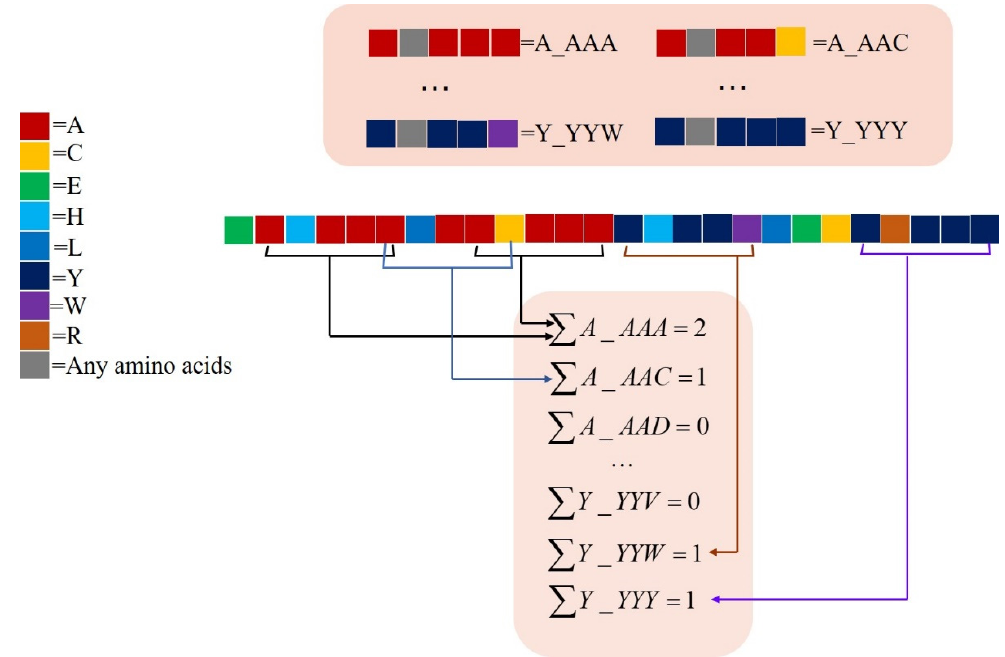
Figure 3. The calculation principle of the protein sequence expressed by monoTriKGap is explained. In this study, KGap = 1 was set, and the character was represented as X_XXX, where X represents 20 kinds of natural amino acids. By calculating the frequency of occurrence of each feature X_XXX, the feature value was obtained.